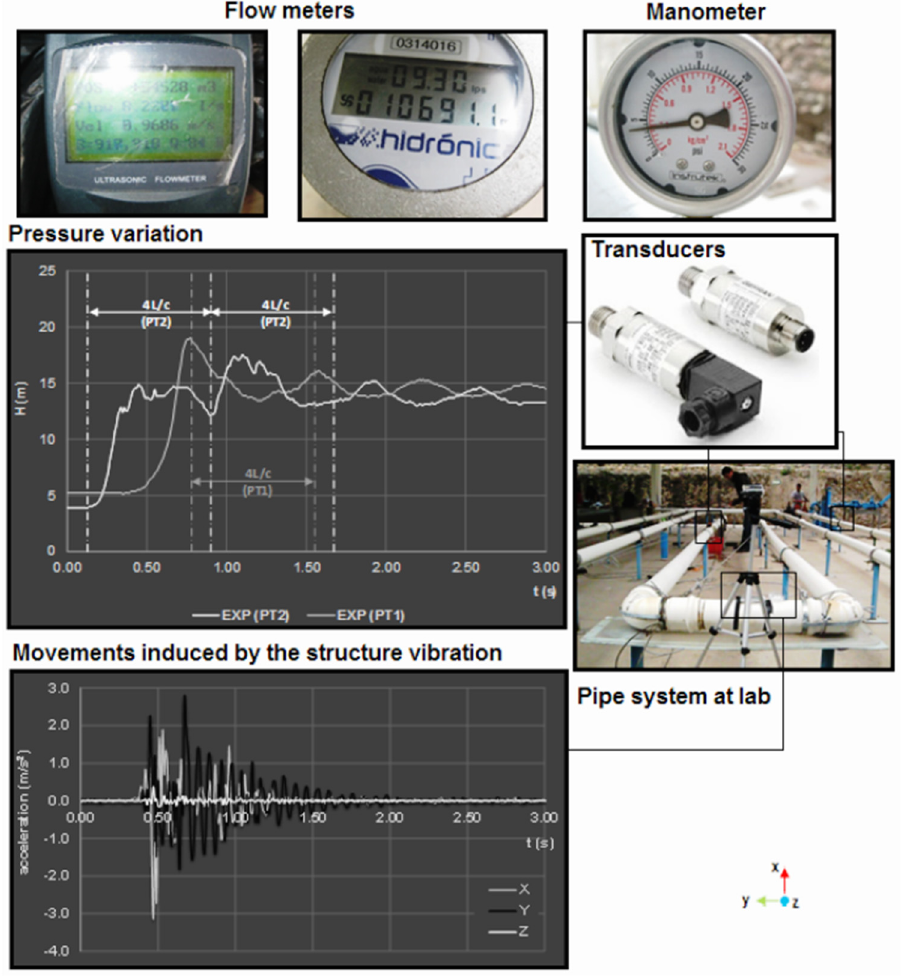
Figure 2. Data acquisition in the laboratory